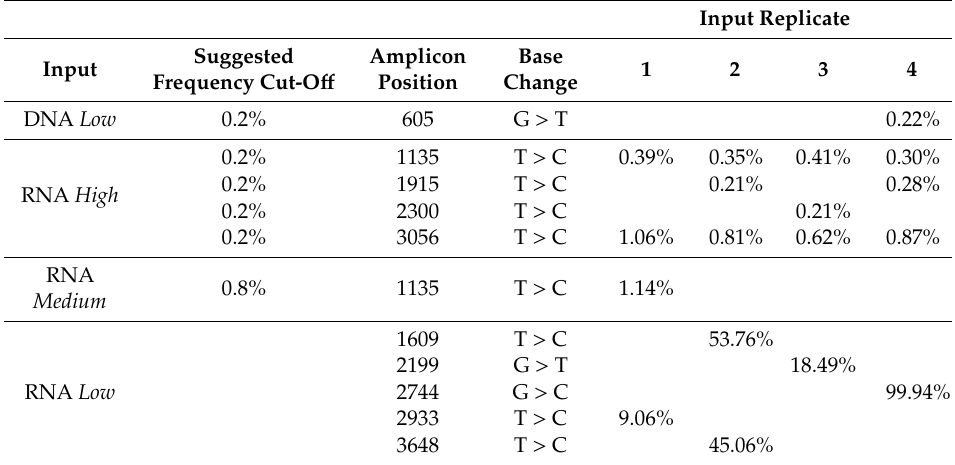
Table 3. The percentage frequency and base change of each FP identified above the recommended frequency threshold for each population input and replicate. For the RNA Low input, a suggested frequency cut-o ff was not